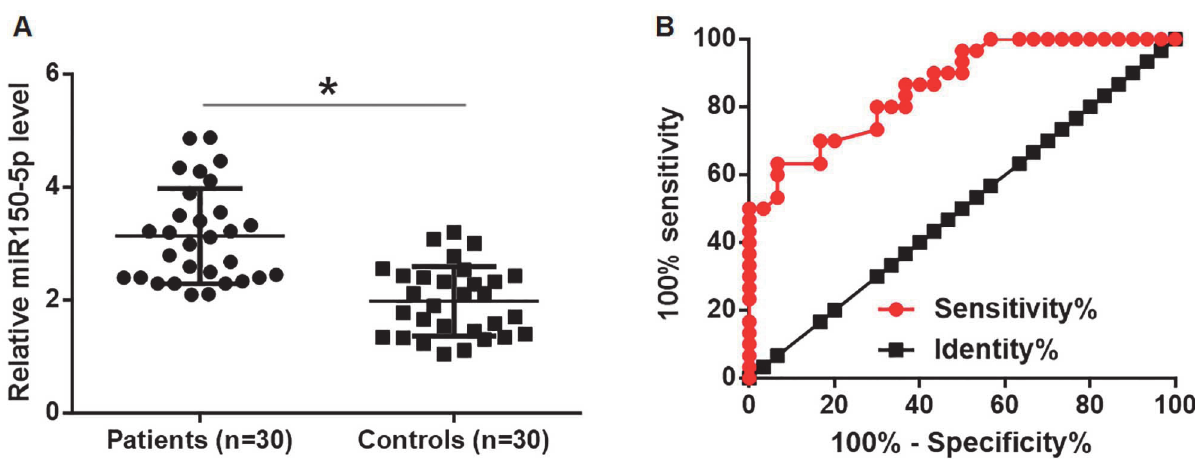
Fig. 1. Upregulation of miR150-5p distinguished generalized myasthenia gravis patients from healthy controls. Serum levels of miR150-5p were significantly higher in generalized myasthenia gravis patients than in healthy controls (A) and upregulation of miR150-5p distinguished generalized myasthenia gravis patients from healthy controls (B) (*, P